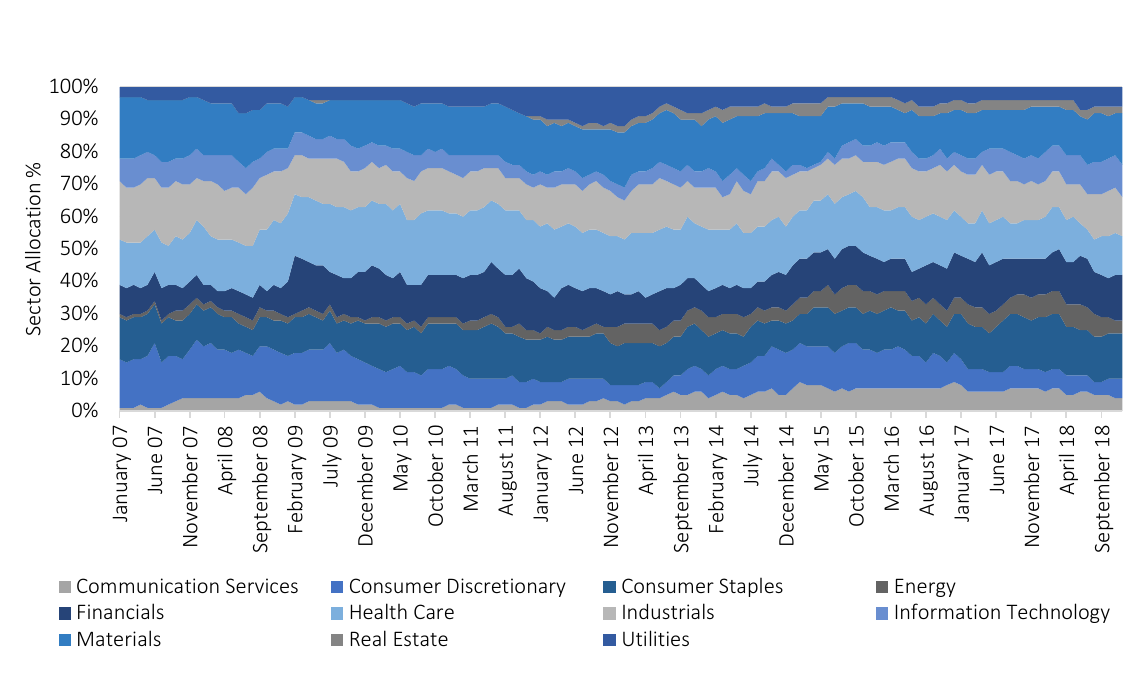
Figure 1a. Volatility sorted low-risk portfolio sector profile